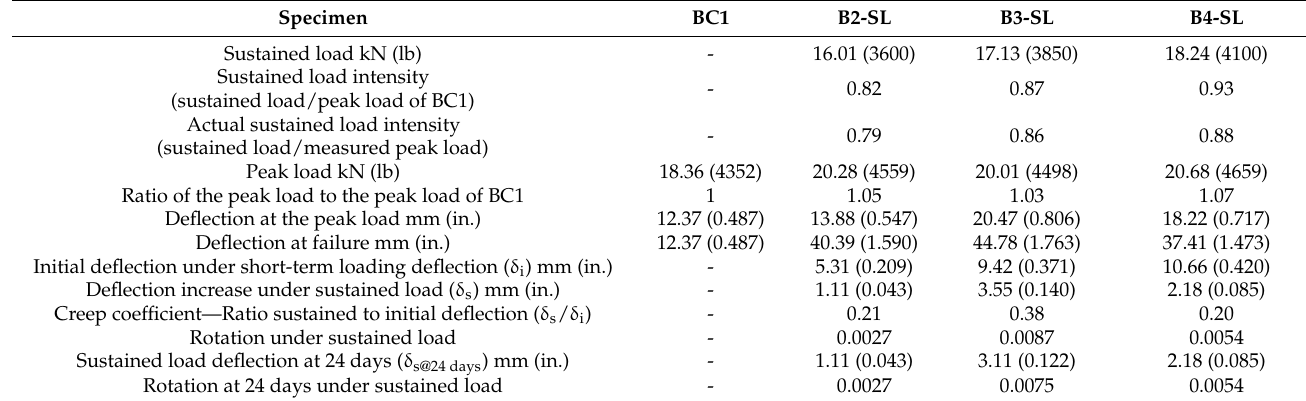
Table 3. Beam series I test matrix and Figure 11. Beam series I failures.